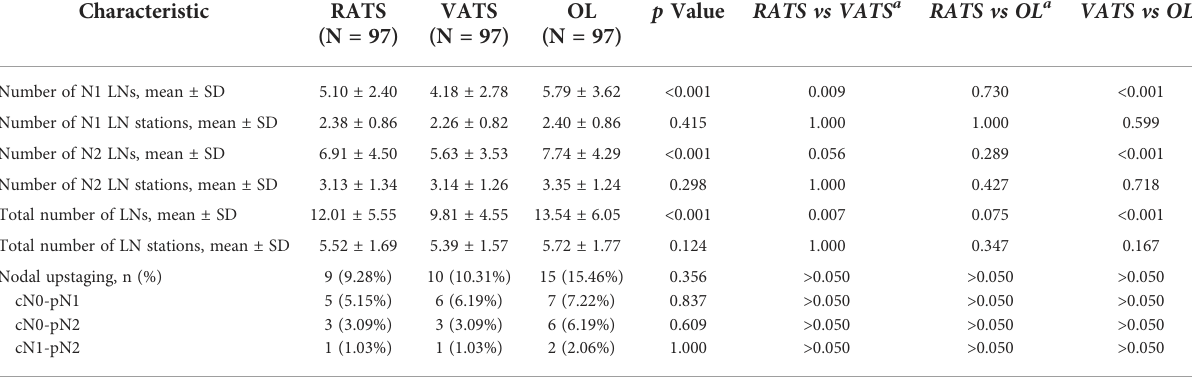
TABLE 4 LNs assessment of matched populations.